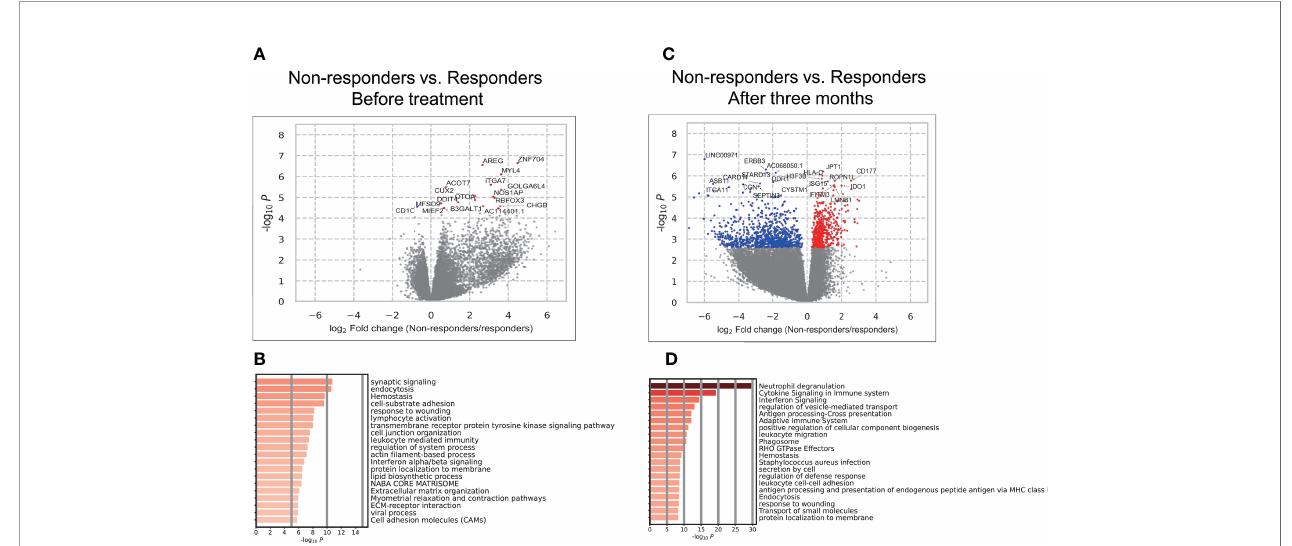
FIGURE 2 | Results of the association analysis of gene expression. (A, C) Volcano plots showing differentially expressed genes (DEGs) in PBMCs between responders and non-responders before treatment (A) . and three months after (C) . Each dot indicates an individual gene, colored in red when a gene was signi fi cantly (FDR < 0.05) up-regulated in non-responders and colored in blue when a gene was signi fi cantly (FDR < 0.05) up-regulated in responders. The gene names of signi fi cant DEGs are shown; when there were more than 20 signi fi cant DEGs, the names of only the top 20 DEGs were shown. (B, D) The results of the enrichment analysis of DEGs before treatment (B) and three months after (D) .